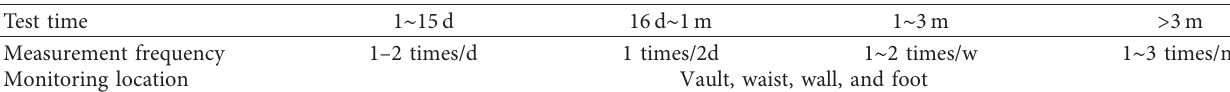
Figure 17: Instrument layout: (a) longitudinal connection of the rebar; (b) longitudinal connection of the channel steel; (c) new longitudinal connection system. Table 5: Monitoring program.